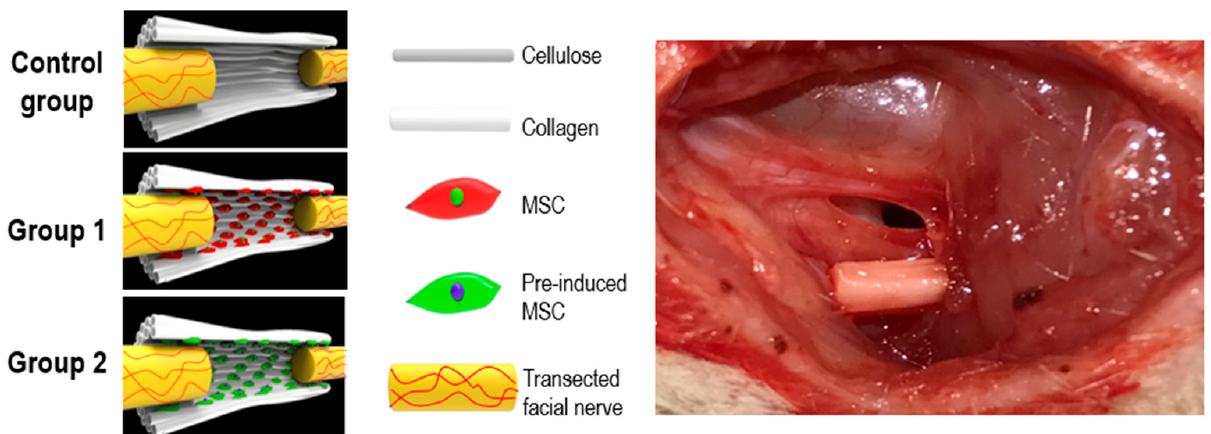
Figure 10. The schematic view of conduit.